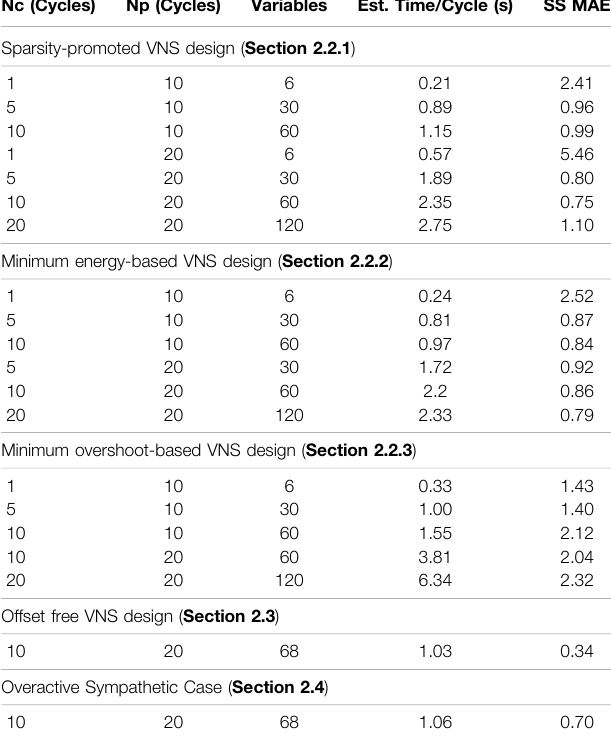
TABLE1| Comparisonofcomputationaltimeandclosed-loopperformanceofthe designed closed-loop VNS strategies. Simulations were performed on an INTEL(R) CORE I7-9700 CPU 3.00 GHZ with 16.0 GB of RAM Desktop. Nc (Cycles) Np (Cycles) Variables Est. Time/Cycle (s) SS MAE Sparsity-promoted VNS design ( Section 2.2.1